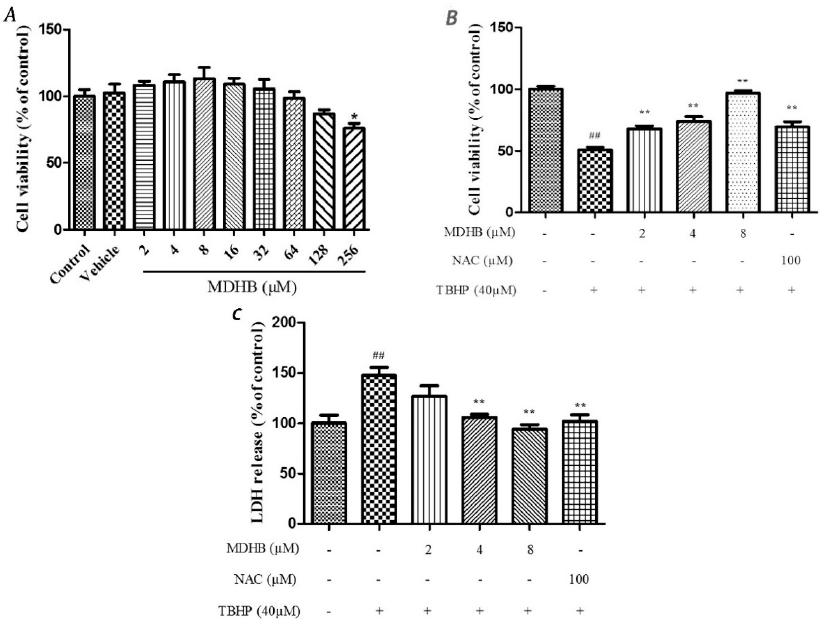
Figure 1. The effect of different concentration of MDHB on TBHP-treated SH-SY5Y cells by MTT assay and LDH assay. ( A ) The safety margin of MDHB. Cell viability was measured by MTT assay. SH-SY5Y cells were cultured with MDHB at 2~128 μ M and 0.1% DMOS for 24 h. Data were normalized by control group. Values represent means ± S.E.M ( n = 4); * p < 0.05 versus the TBHP-treated alone group ( n = 4); ( B ) The cells were pretreated with 2, 4, or 8 μ M of MDHB for 4 h, followed by treatment with 40 μ M TBHP for 24 h. Cell viability was measured using the MTT assay. Data are normalized to the control group. Values represent means ± S.E.M. ## p < 0.01 versus the control group. ** p < 0.01 versus the TBHP-treated alone group ( n = 4); ( C ) Cells were pretreated with 2, 4, or 8 μ M of MDHB for 4 h, followed by treatment with 40 μ M TBHP for 24 h. LDH release was measured. Data are normalized to the control group. Values represent means ± S.E.M. ## p < 0.01 versus the control group. ** p < 0.01 versus the TBHP-treated alone group ( n = 4).